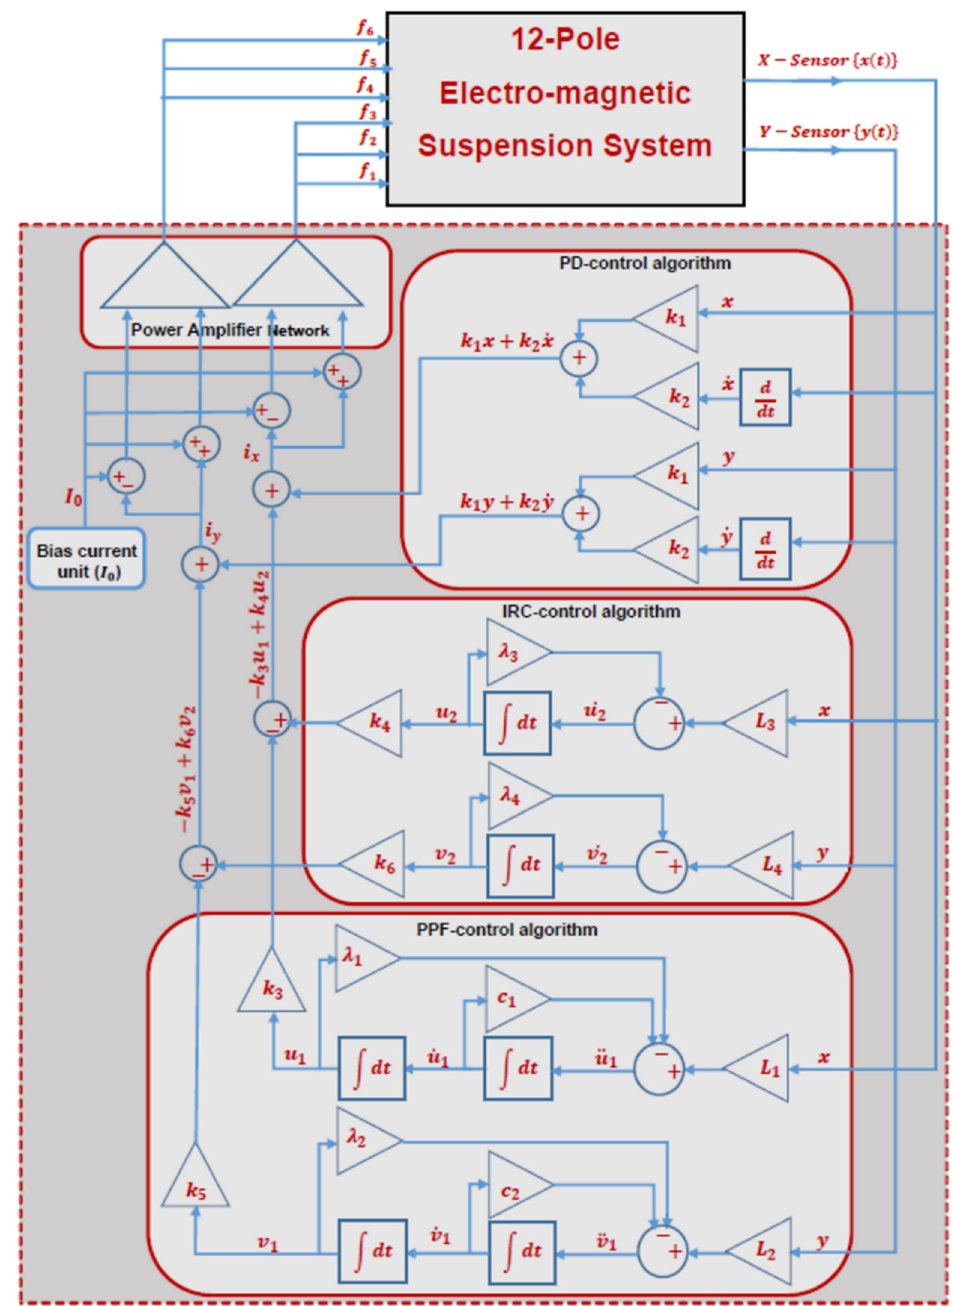
Figure 2. The engineering implementation of the combined control algorithm (i.e., PD + IRC + PPF controller).